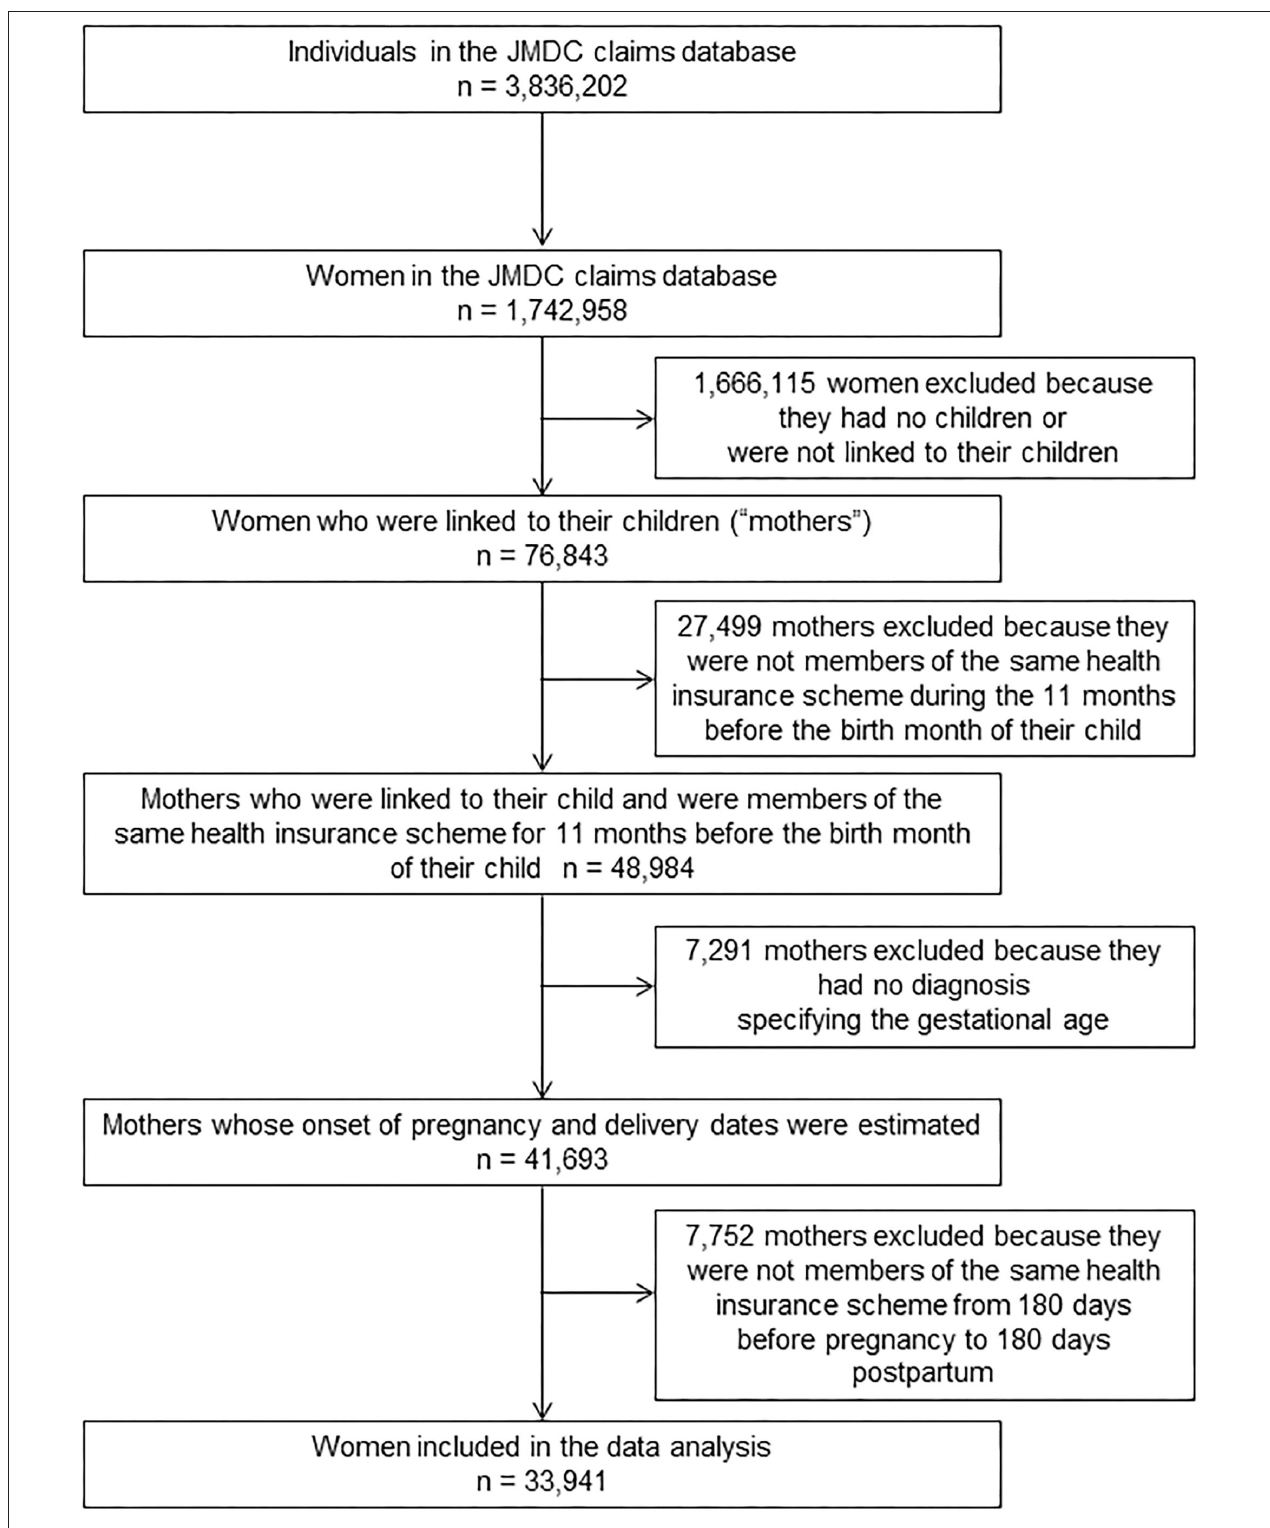
FIGURE 1 | Flowchart of patient selection for inclusion in this study.